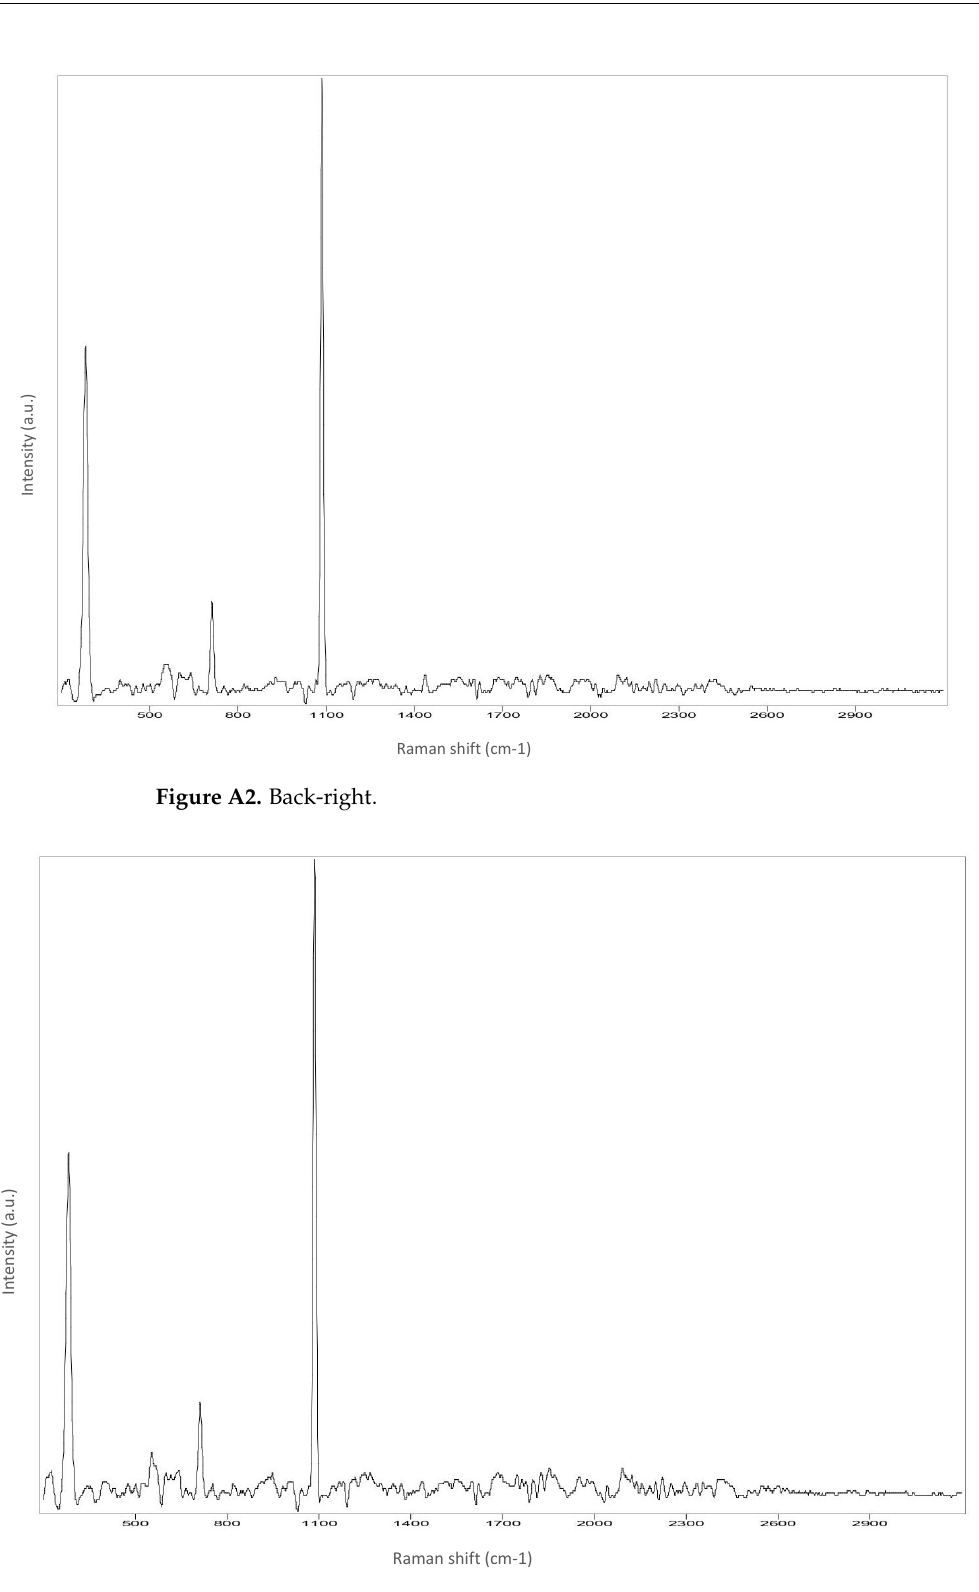
Figure A3. Left cheek.